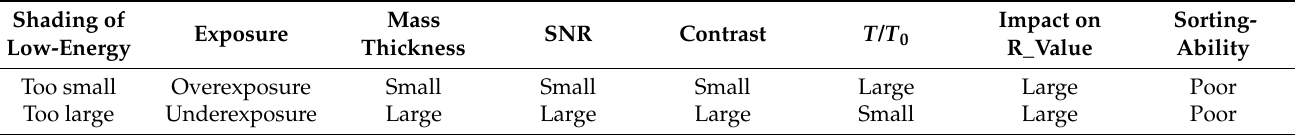
Table 1. Influence of XRT parameters on